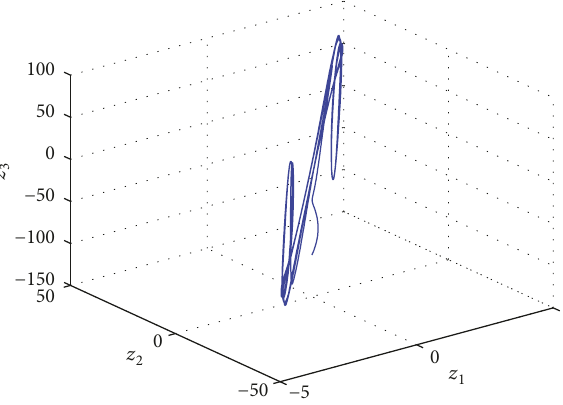
Figure 4: The phase portrait of tracking errors 𝑧 1 , 𝑧 1 , and 𝑧 3 .